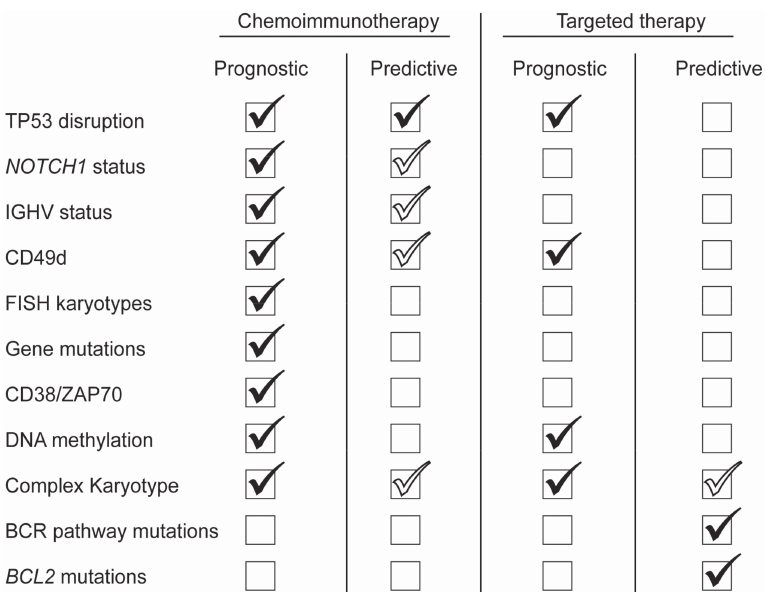
Figure 1. Prognosticators / Predictors in the context of chemoimmunotherapy and targeted therapy. Filled check marks identify biomarkers with a reported prognostic or predictive value in the setting of chemoimmunotherapy (left) or in the era of chemotherapy-free treatment with either Bruton’s tyrosine kinase, phosphoinositide 3-kinase inhibitors or B-cell lymphoma-2 (BCL2) inhibitors (right). In the context of chemoimmunotherapy, TP53 disruption is the only “true” predictive biomarker by consensus; other “proposed” predictive biomarkers are represented by empty check marks. TP53 disruption includes TP53 mutation and / or del17p; FISH karyotype: del11q, trisomy12, normal cytogenetics and del13q; gene mutations: BIRC3 , SF3B1 . Abbreviations: IGHV, immunoglobulin heavy chain variable gene; ZAP70, zeta chain associated protein 70; BCR, B-cell